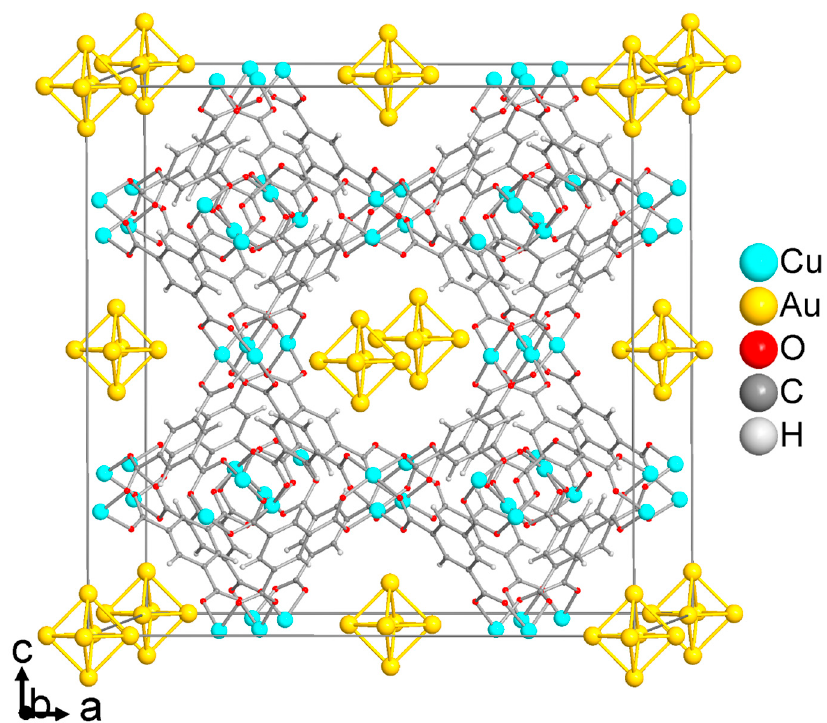
Figure 9. Section of the packing diagram of HKUST-1 with Au clusters in the medium-sized pores. The appearance of an ideal octahedral Au cluster is an artifact from the cubic symmetry where a single Au atom placed off-center in the pore will be positioned at the vertices of an octahedron by symmetry. The Au···Au separation along the edges of the octahedron was set to 2.8 Å. The electron density of the Au cluster was adjusted to correspond to five Au atoms in the pore. For the illustration, the solvent-free structure of HKUST-1 with CSD-Refcode DOTSOV, CCDC 697917 [55], was used.